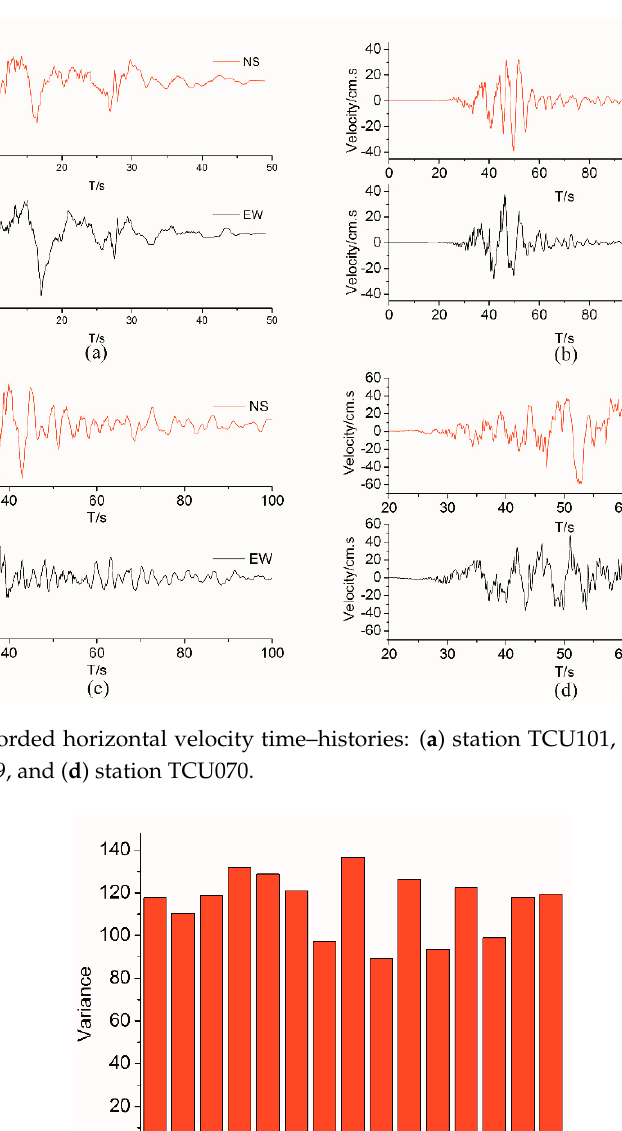
Figure 7. The resultant time–frequency plane 𝑪 (cid:3019)(cid:3020)(cid:3021) for the signal set at station TCU101. Figure 8. The early arrival of pulse energy by the CSV curves for the signals at station TCU101, ( a ) S (cid:2968) , ( b ) P (cid:2968) , and ( c ) CSV curves for signal S (cid:2968) and P (cid:2968) . The horizontal direction containing the largest pulse energy for the signals at station TCU101 was 59.09° from north to east, while the strike angle of the Chi-Chi event was 5 ° . The largest pulse energy theoretically lay in the direction normal to the strike line [7], at 95 ° . There was an error ~34.35% between the direction from analysis and theory. This error may result from both the